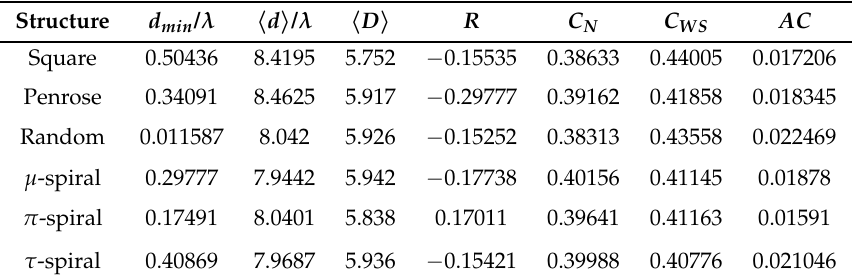
Table 1. Geometrical and graph-based parameters of the